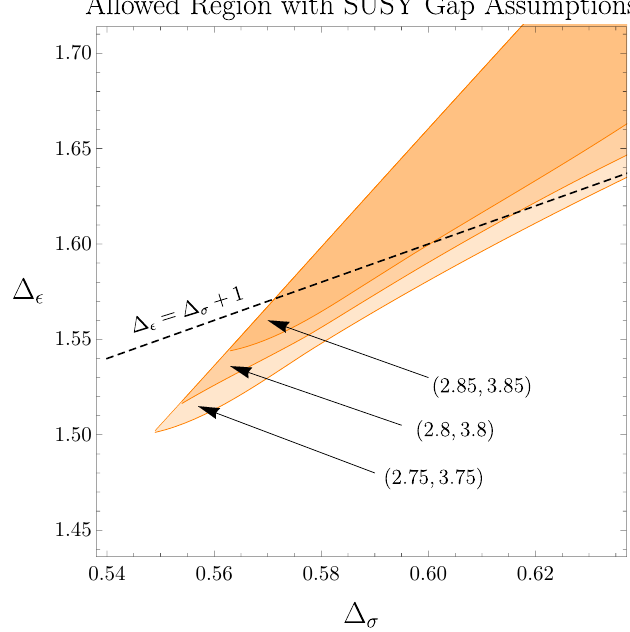
Figure 3 . The shaded areas show the non-excluded regions at various gap assumptions. Here we assume a third relevant parity-odd operator (cid:27) 0 , together with the relevant operators (cid:27) and